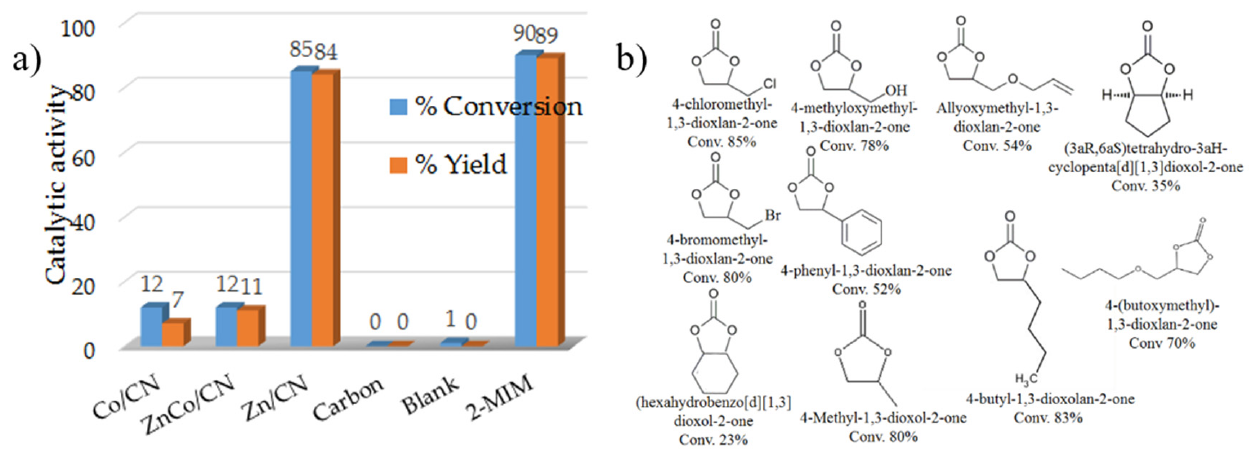
Figure 6. ( a ) Catalytic performance of synthesized porous carbon materials obtained from different ZIFs and pyrolysis temperature. ( b ) Variety of cyclic carbonates produced by Zn/CN as catalyst. Conversion and yields were determined by 1 H NMR and using 1,3,5-trimethylbenzene as the internal standard. The details of experiments are provided in Table S3.